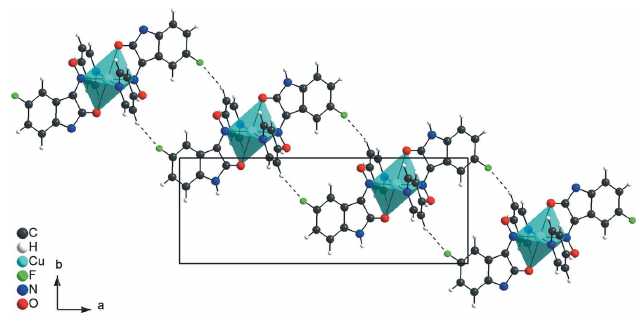
Figure 3 Partial crystal packing of the title compound, viewed down the c axis, showing the C—H (cid:2)(cid:2)(cid:2) F interactions (dashed lines) forming rings of R 2 graph-set motif connecting the molecules into a chain along the [110] direction.